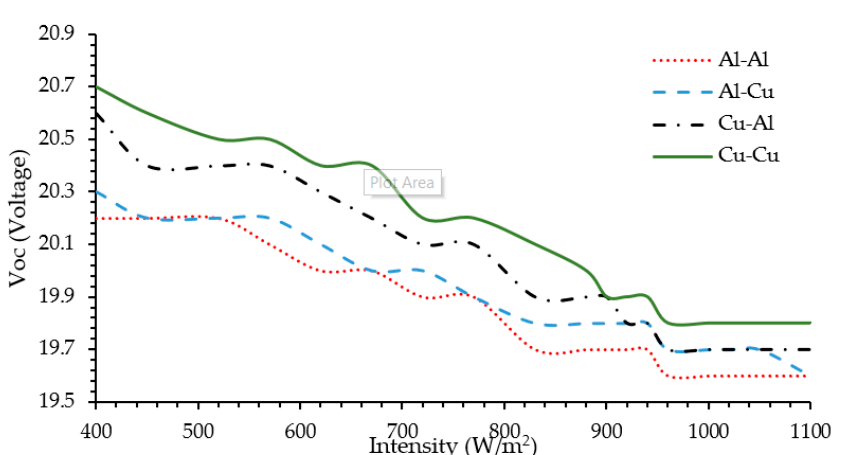
Figure 9. Isc from the material change.